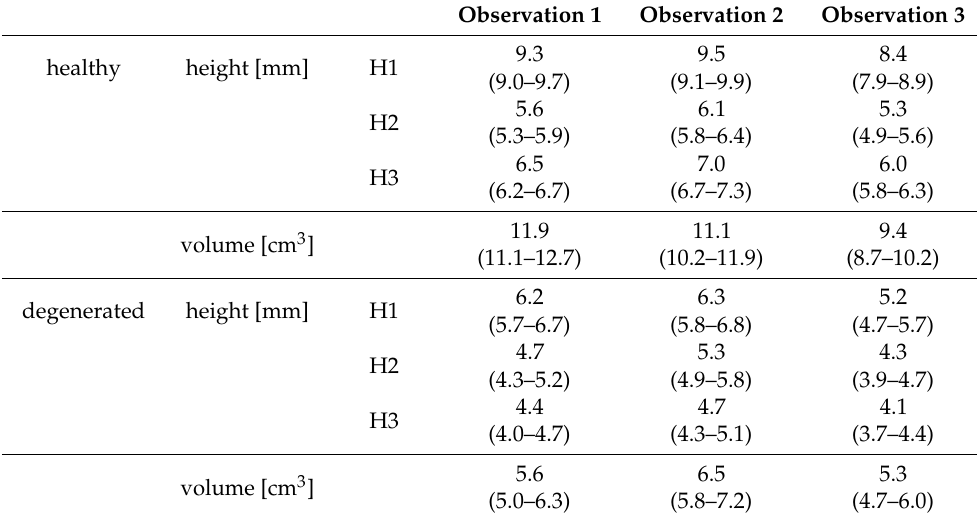
Table 1. Measured disc heights and volumes of the healthy and degenerated lumbar disc. Values are displayed as the mean, and in brackets, the lower and upper limits of the 95% confidence interval. H1: disc height in the center of the midsagittal plane; H2: mean disc height of the ventral and dorsal measured disc height in the midsagittal plane; H3: mean of nine measuring points. Observation 1 and 2 are the results from observer 1 at two different time points. Observation 3 was performed by a second observer. Observation